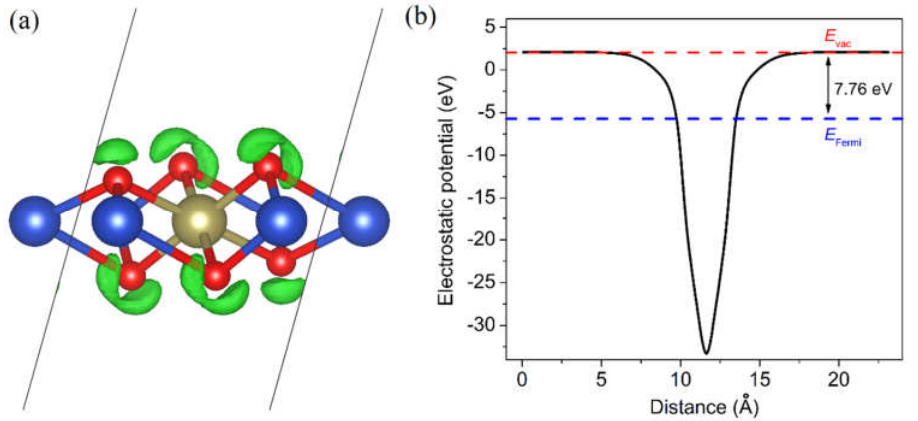
Figure 3. ELF with the isosurface value of 0.70 for the Cu 2 TeO 6 monolayer ( a ) and WF for the Cu 2 TeO 6 monolayer ( b ). Cu 2 TeO 6 monolayer ( b